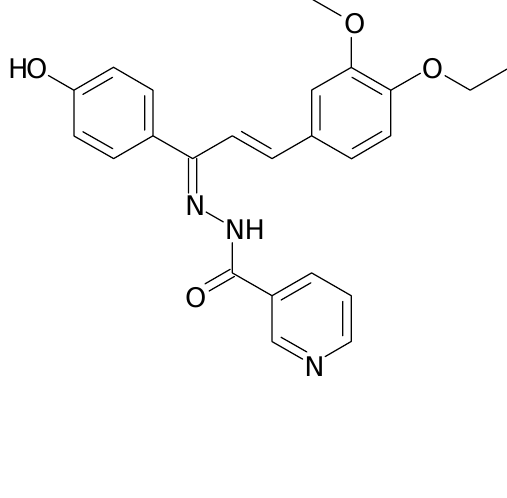
Figure 4 . A potentially new haem-targeting antimalarial compound discovered by virtual screening: nicotinic acid [trans-3-(4-ethoxy-3-methoxyphenyl)-1-(4-hydroxyphenyl)- allylidene]-hydrazide